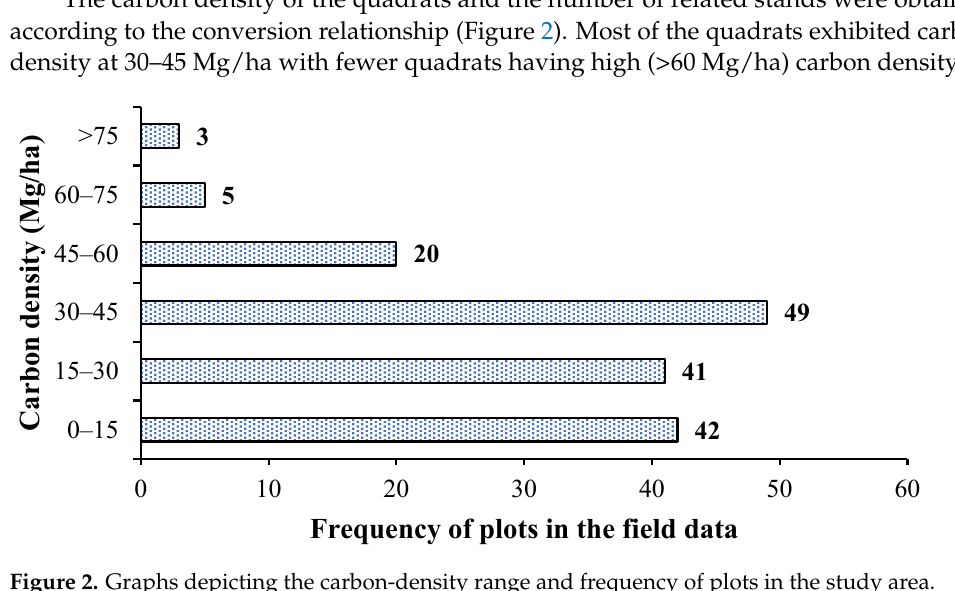
Table 1. Allometric growth equations of major tree species in the study region, where W is the AGB, D is the DBH, and H is the tree height. Tree Species Model Expression and the Parameters Cunninghamia lanceolata group W = 0.0492Power(D, 2.660) Pinus massoniana group W = 0.1309Power(D, 2.4367) Hard broadleaf group W = 0.0710Power(D 2 H, 0.9117) Soft broadleaf group W = 0.1351Power(D 2 H, 0.8020)